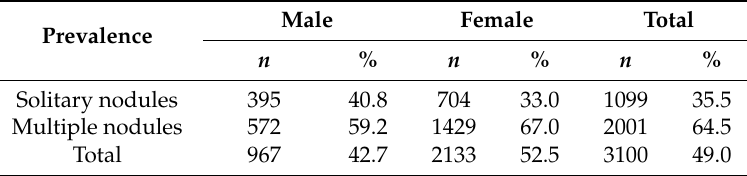
Table 2. The prevalence of thyroid nodules in subjects.